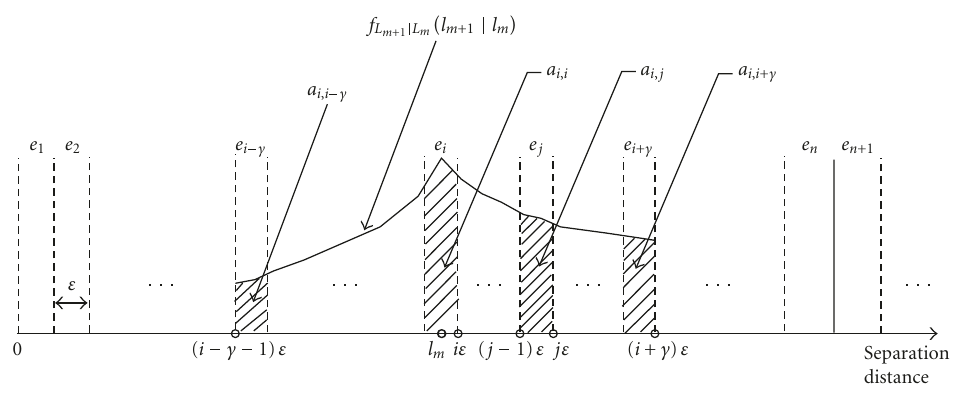
Figure 2: Depiction of state space for the nonabsorbing state model, showing the state transition probabilities, a i , j , the probability of trans- ferring from e i to e j after one epoch, for a given state i and various states j .